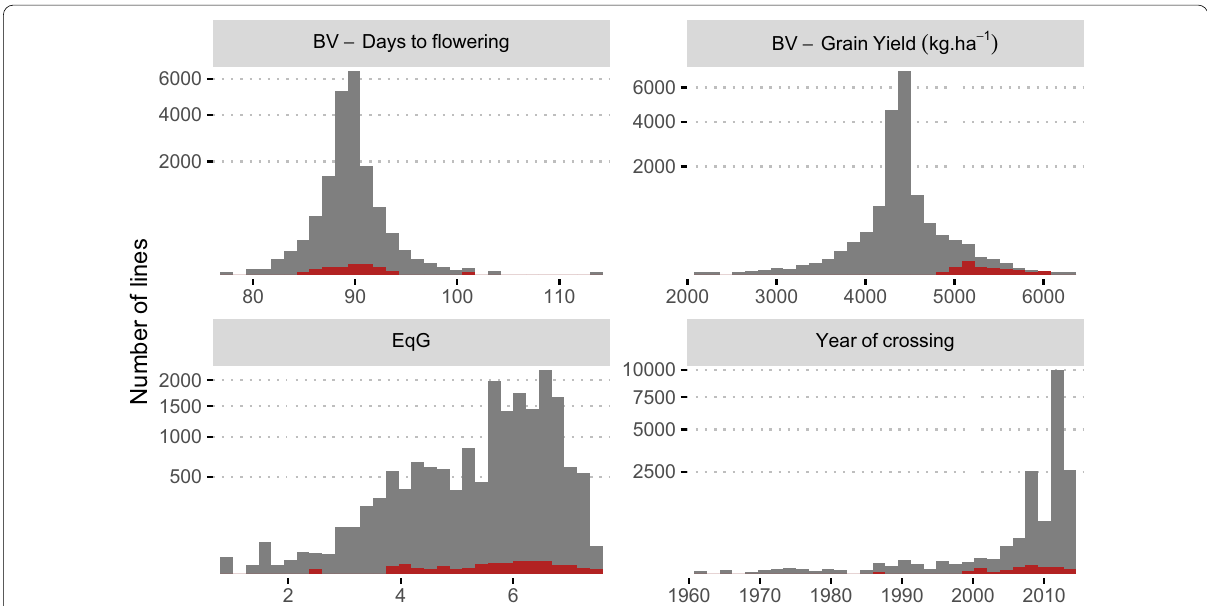
Fig. 5 Distribution of 72 elite core panel (ECP) lines among the complete data set. The ECP lines are in red and the rest in grey. Four parameters are represented: breeding values (BV) for days to flowering and grain yield, the equivalent complete generation metric (EqG) and the year the cross was initially made a given